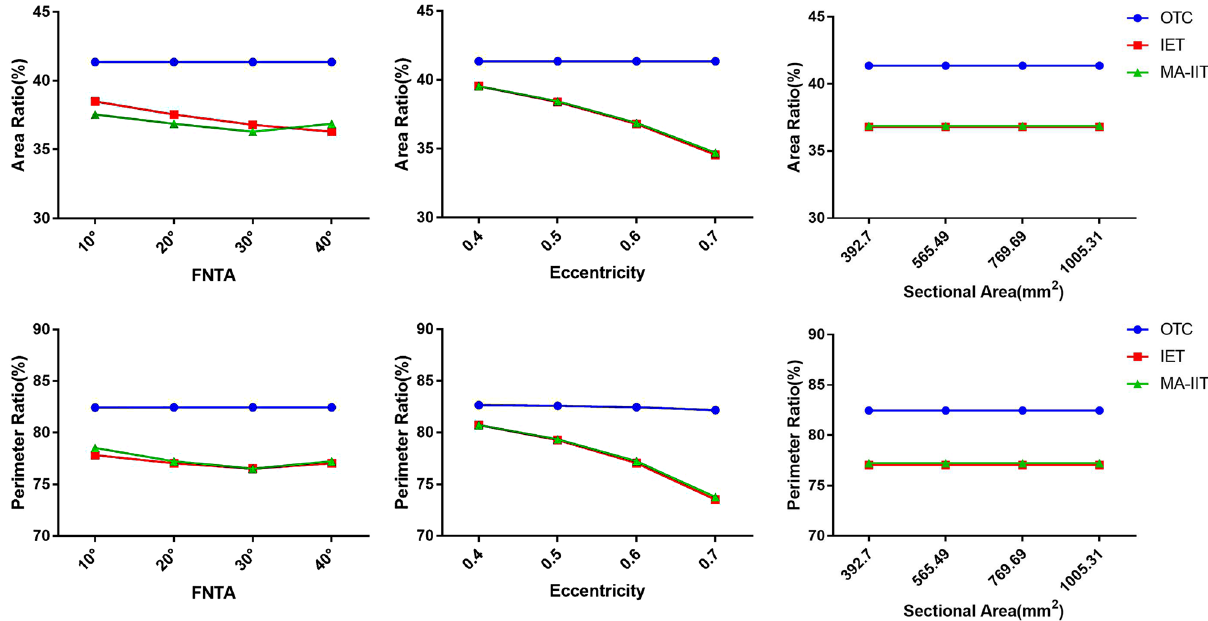
Figure 6. In the univariate evaluation model, the area and perimeter ratio of OT, IET, and MA-IIT under different variables. The area and perimeter ratio of OTC were stable under the given variables (torsional angle, area, and eccentricity) in the torsional ellipse model. The area ratio and circumference ratio of IET and MA-IIT decreased with the increase of the torsion angle and eccentricity of the ellipse, while parameters of OT were not affected by the area of the